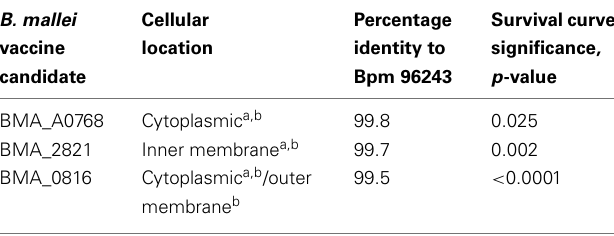
Table 3 | Characteristics of individually protective subunit vaccine